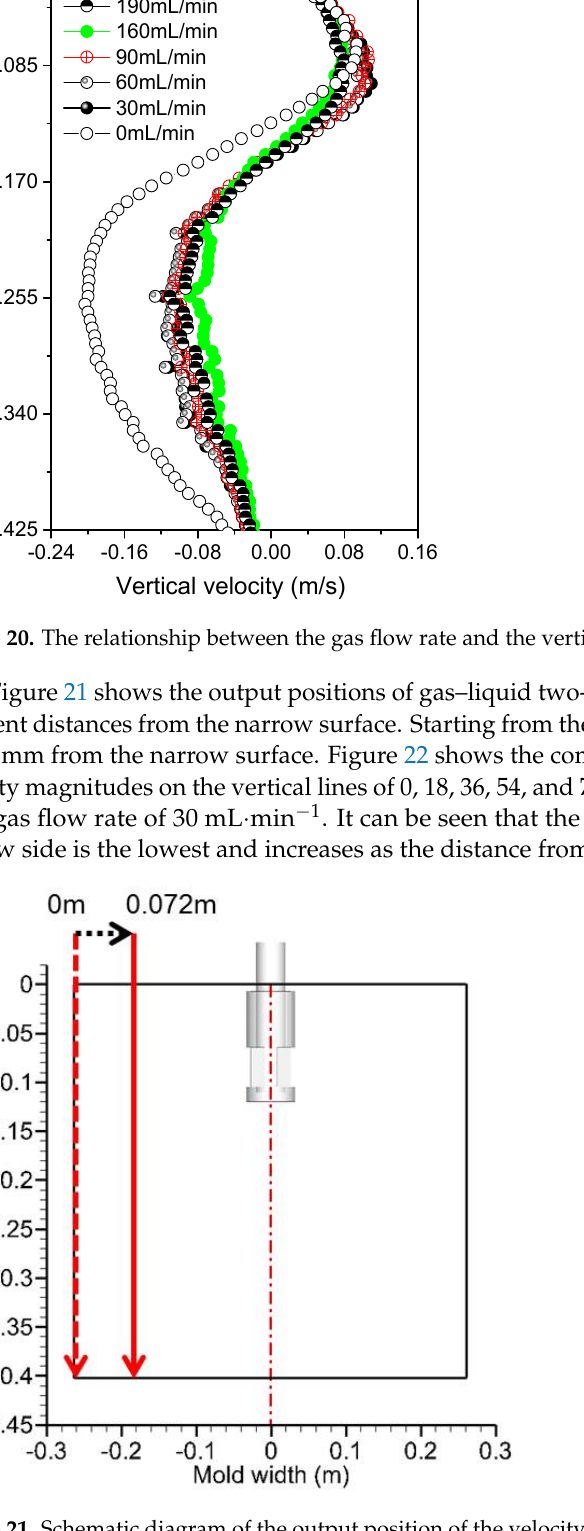
Figure 21. Schematic diagram of the output position of the velocity and velocity at different distances